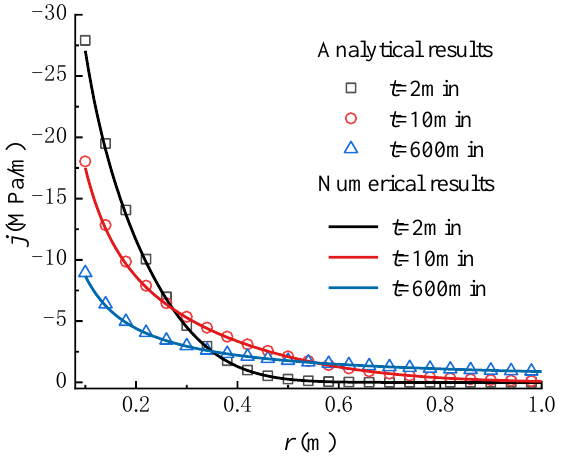
Figure 4. Comparison of the pore pressure versus distance from the wellbore wall between the an-